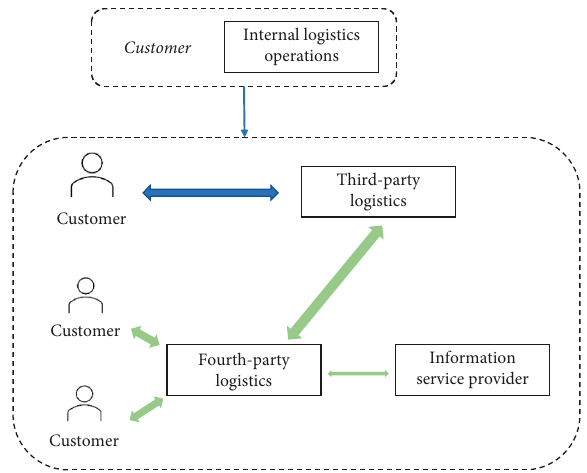
Figure 1: Relationship between third-party logistics and fourth- party